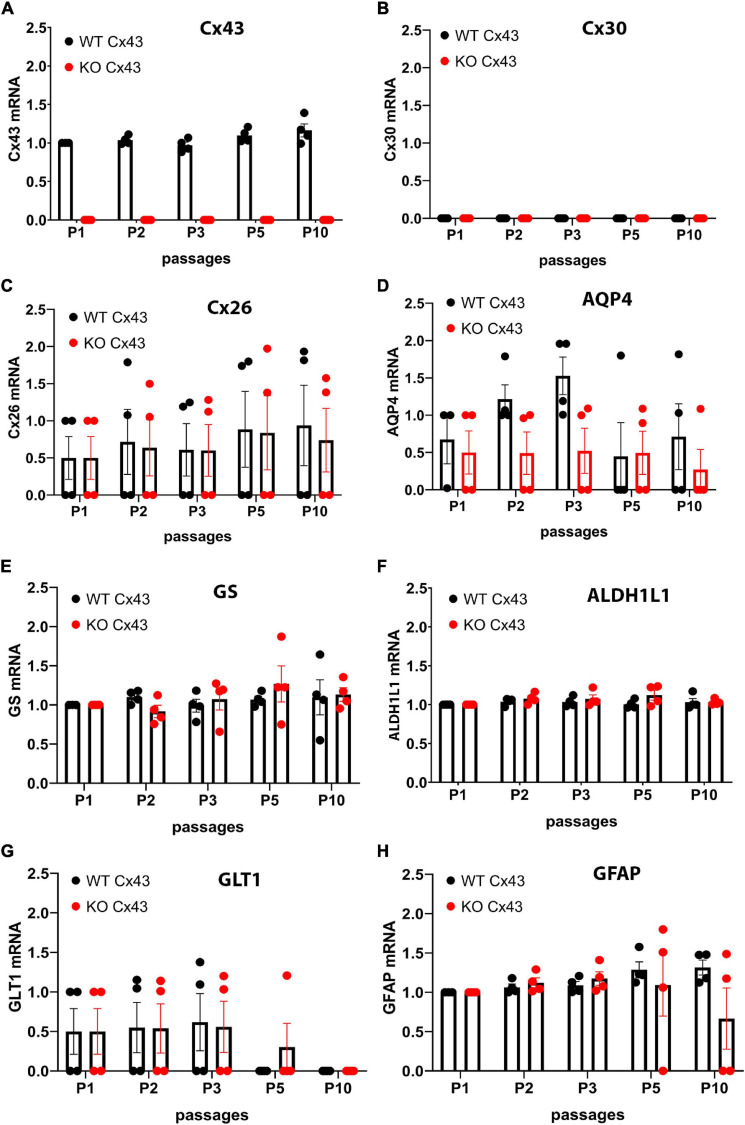
Quantitative RT-PCR showing expression levels of mRNAs encoding astrocyte proteins during ten passages after transduction. Expression levels of astrocyte biomarkers in the immortalized wildtype (IWCA) and Cx43-null (IKOCA) cortical astrocyte cell lines. Expression levels measured at each time point up to 10 passages after transduction with hTERT are normalized to those of IWCA astrocytes before transduction (labeled passage 1 in the histograms). Points in histograms correspond to individual cell lines and bars and variance correspond to mean ± SE values from the four independent clones generated for each of the two genotypes. (A) Cx43 levels are stable in IWCA up to 10 passages, whereas Cx43 expression is absent in all of the IKOCA lines. (B) Cx30 was not detectable in either IWCA or IKOCA, either before immortalization or at any time point thereafter. (C) Cx26 is present in both IWCA and IKOCA and is relatively stable in both genotypes with continued passaging. (D) Levels of AQP4 transcript in both IWCA and IKOCA, with the lowest levels at passage 10 being about 20% that of those in primary cells. (E,F) Transcript levels of the astrocyte markers glutamine synthetase (GS) and aldehyde dehydrogenase (ALDH1L1) were remarkably stable over the 10 passages examined. (G) mRNA for the glutamate transporter (GLT1) were lower than in primary cells but similar between genotypes and declined after passage 5 in both genotypes to reach undetectable levels at passage 10. (H) Levels of the astrocyte intermediate filament transcript GFAP was stable in both genotypes but was low in two of the IKOCA cell lines at passage 10.